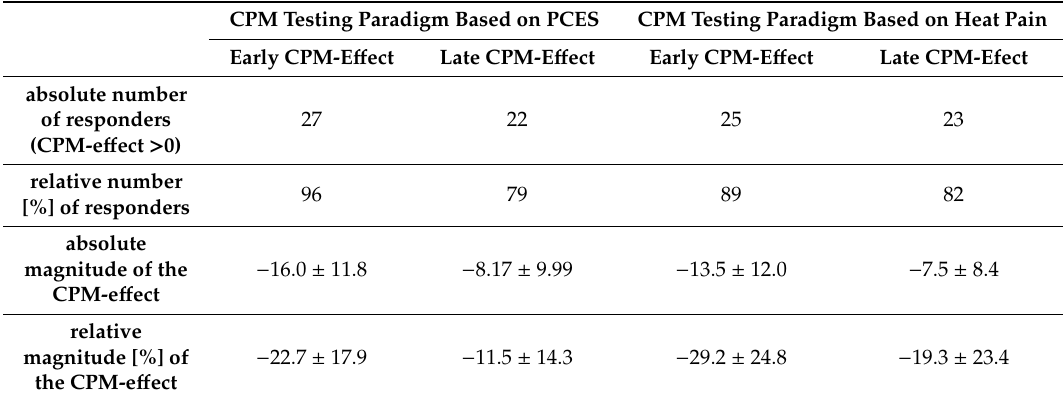
Table 3. Conditioned pain modulation based on PCES and heat as test stimulus (TS).